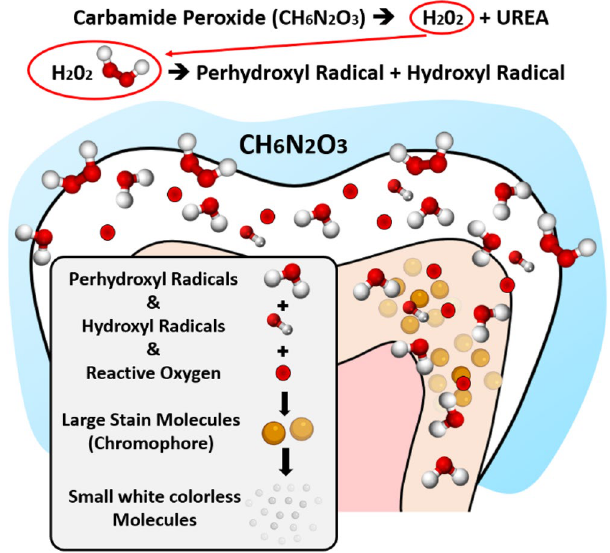
Figure 1. Synopsis of carbamide peroxide teeth-whitening